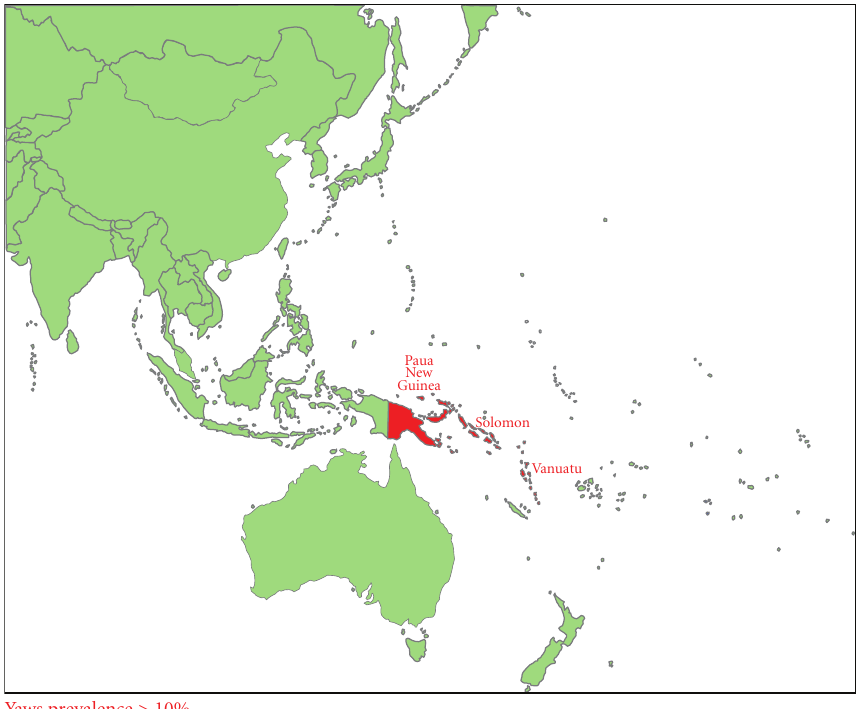
Figure 3: Yaws prevalence in the Western Pacific Region in the